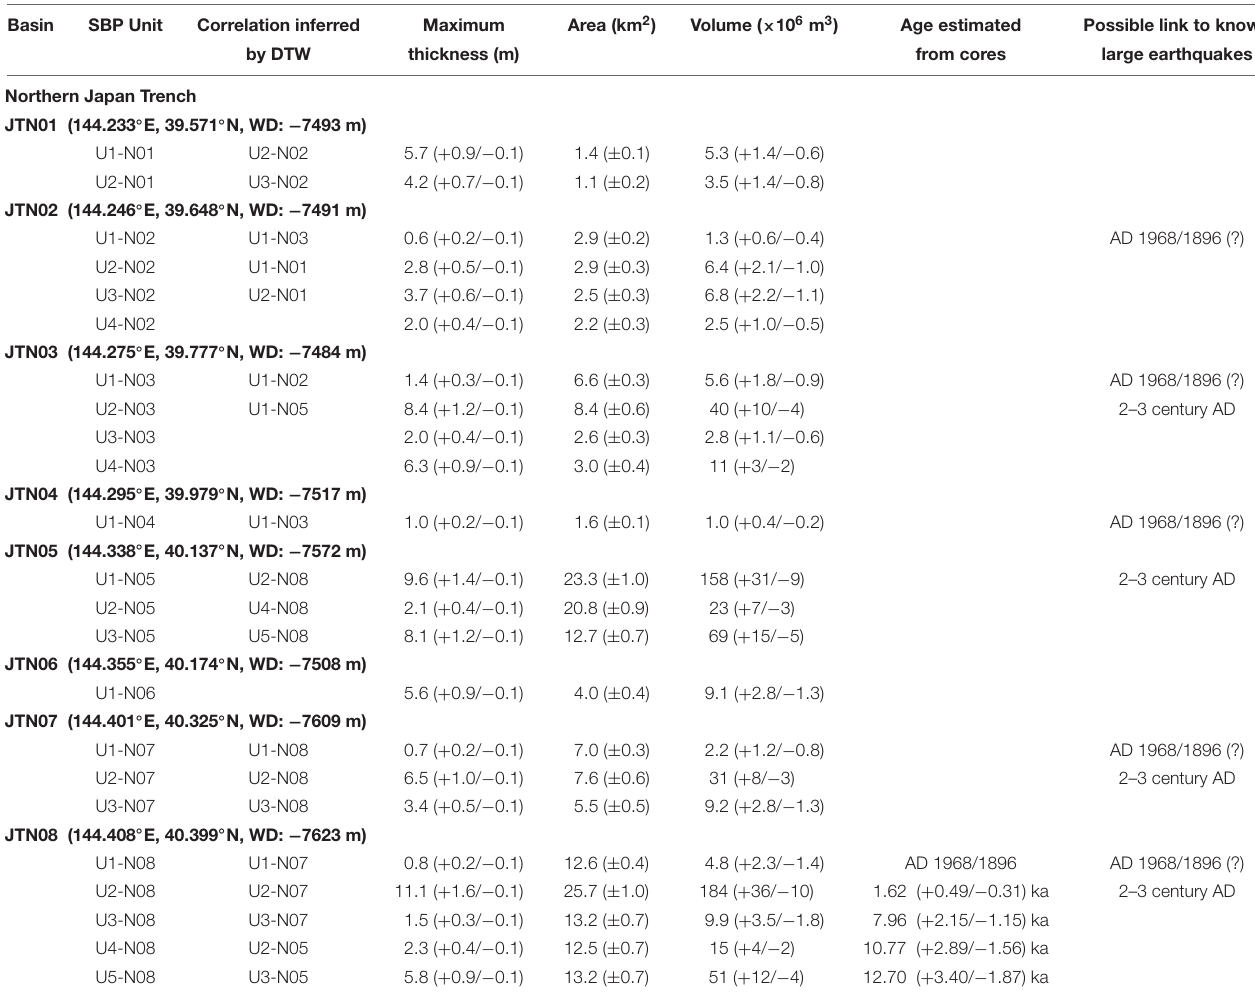
TABLE 3 | Longitude, latitude and water depth (WD) of modern depocenter, acoustically transparent SBP body units, correlation to neighboring SBP units inferred by DTW, maximum thicknesses, areal extents and volumes of identified event deposits, estimated ages from cores, and possible links to historically known large earthquakes at a given trench fill-basin in the northern Japan